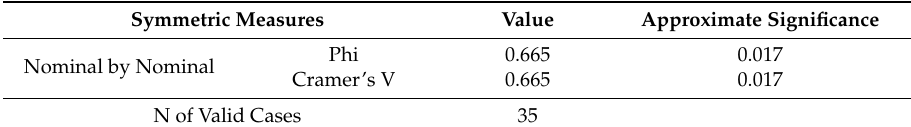
Table A7. Symmetric measures: Game * Gender.